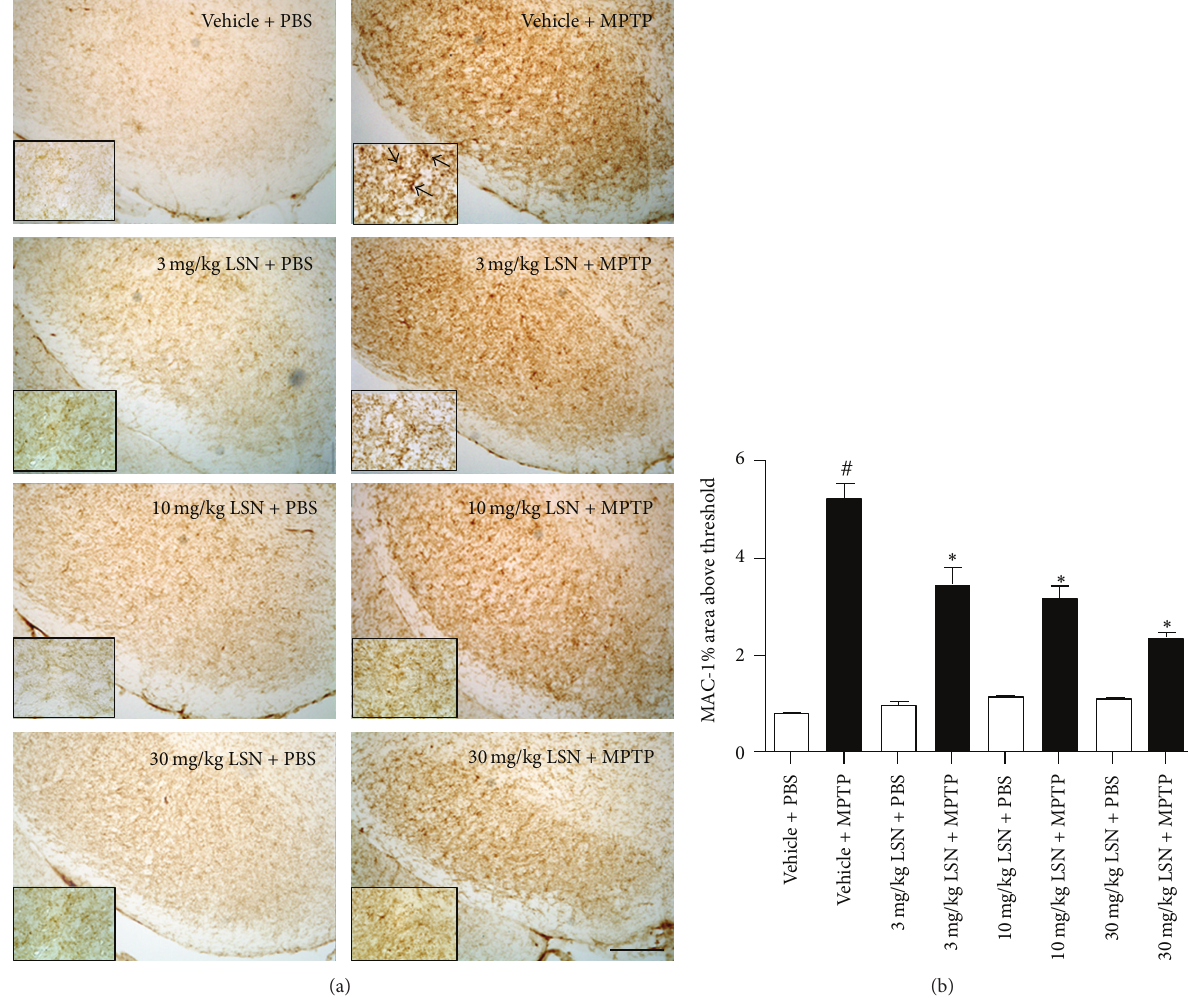
Figure 5: LSN862 (LSN) prevented MPTP-induced microglial activation. Mice brains were evaluated 21 days after completing MPTP or PBS challenge and 24hrs after daily treatment with LSN. (mean ± SEM; 𝑛 = 4 – 7 per group). (a) Coronal images at the level of the substantia nigra (SN) immunostained for MAC-1 (cd11b). Insets correspond to high magnification images. Scale bar: low magnification = 100 𝜇 m, high magnification = 25 𝜇 m. (b) Quantification of nigral MAC-1 immunoreactivity. ANOVA Fisher’s LSD post hoc, # 𝑃 < 0.05 (vehicle + PBS versus vehicle + MPTP), ∗ 𝑃 < 0.05 (vehicle + MPTP versus 30mg/kg LSN +